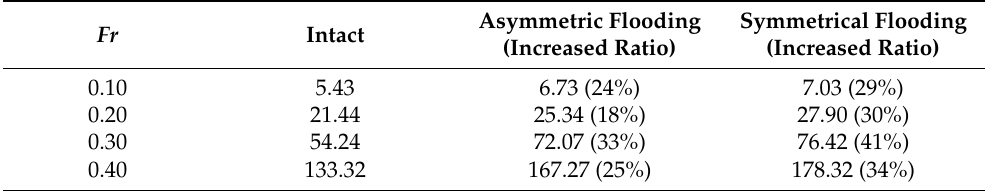
Table 13. The comparison of ship total resistance in the intact, symmetrical flooding and asymmetric flooding cases (unit: N).